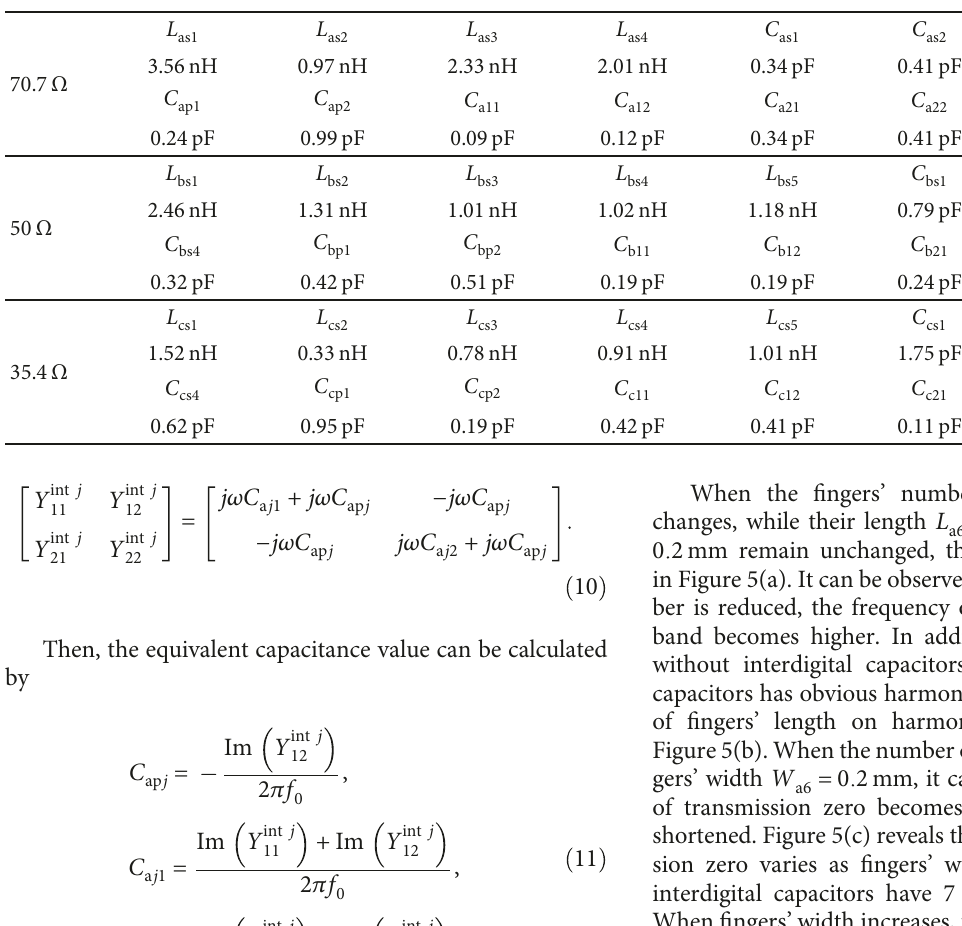
Table 1: Detailed element parameters of